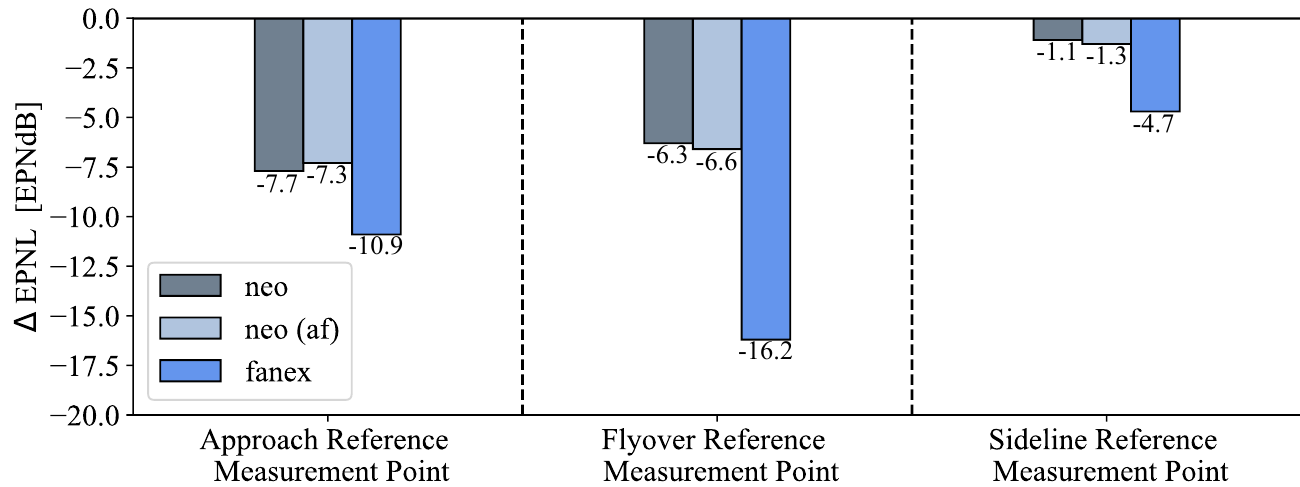
Figure 7. Reduction of certification levels for studied aircraft designs ( neo , neo ( af ), fanex ) relative to reference aircraft zero at three reference measurement points Approach, Flyover and Sideline.